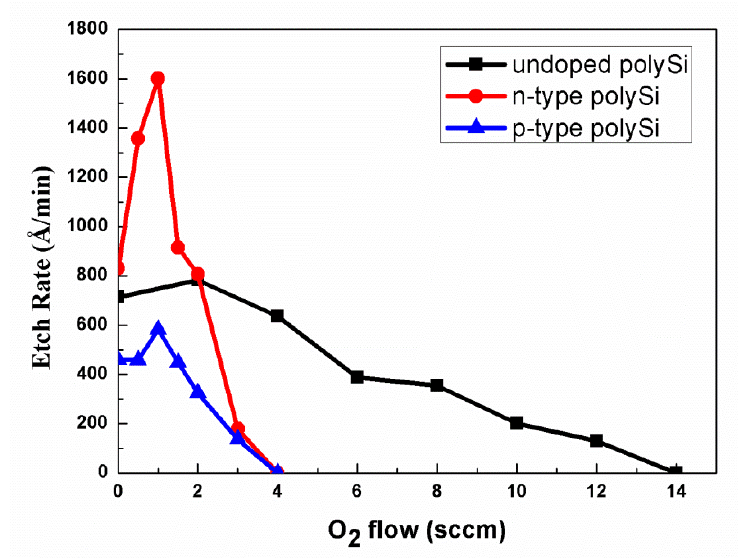
Figure 3. The etch rate of three types of polysilicon under di ff erent O 2 flow.